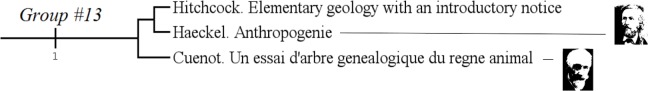
Subtree showing the group #13 (called “Aesthetic trees”).